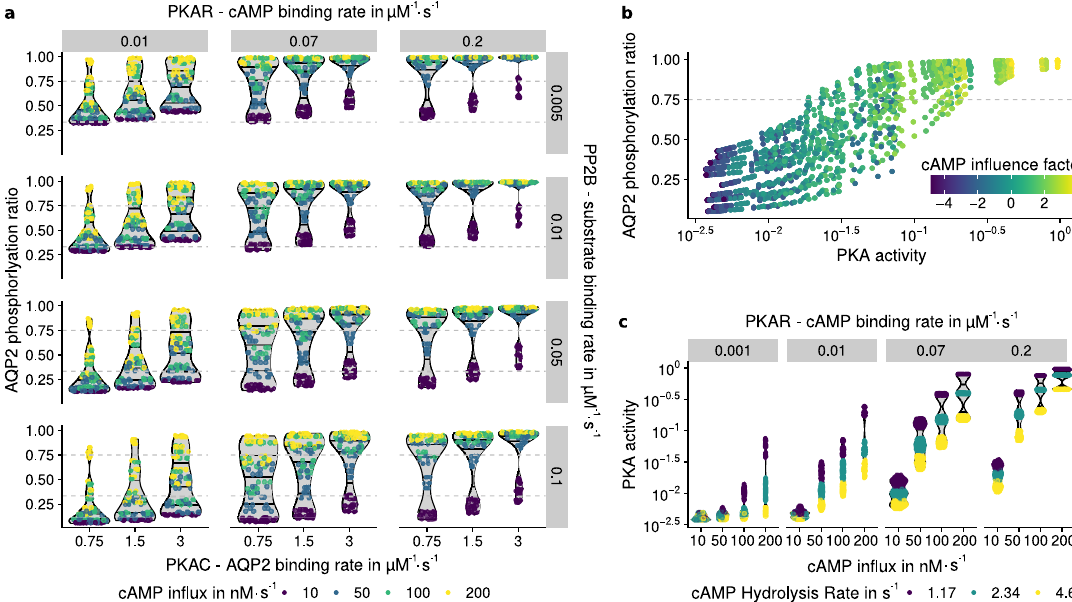
Fig. 3 Simulation results of PKA and AQP2 phosphorylation. Simulations with different parameter combinations were run for 5 minutes and the resulting phosphorylation ratios and have been measured. Basal phosphorylation (0.46) and threshold AQP2 phosphorylation ratio (0.75) are shown as gray dashed lines. cAMP in fl ux describes the cAMP concentration entering the system every second produced by adenylyl cyclases. a High cAMP in fl ux (indicated by color) is a major determinant for phosphorylation. Low PP2B binding rate (increasing from top to bottom) leads to an increased concentration of PKAC in the simulation and higher phosphorylation rate, whereas a high PKAR-cAMP binding rate (increasing from left to right) leads to a high phosphorylation rate nearly independent of the cAMP in fl ux. Horizontal lines are drawn in the background density estimates at 25%, 50%, and 75% quantiles. b cAMP in fl uence factor is calculated by log (cAMP in fl ux ⋅ cAMP binding). High cAMP in fl uence on the simulation leads to high PKA activation and subsequent AQP2 phosphorylation. Physiological parameters for PKA activity should be able to reach AQP2 phosphorylation required (0.75), but still be sensitive to shifts in cAMP concentration. c cAMP hydrolysis mediated through PDE4 signi fi cantly in fl uences PKA phosphorylation, depending on the cAMP in fl ux and PKAR-cAMP binding